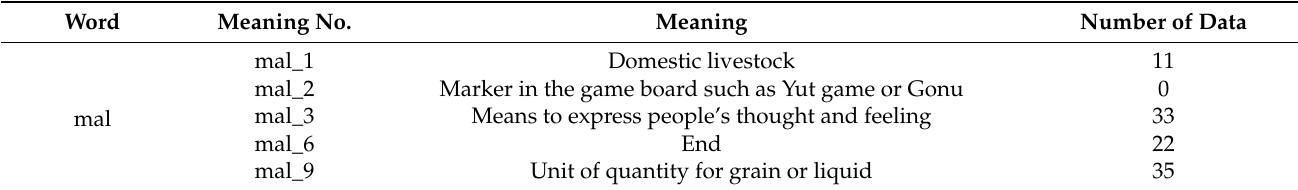
Table 8. Example of ‘SENSEVAL-2 Korean Learning Data’.